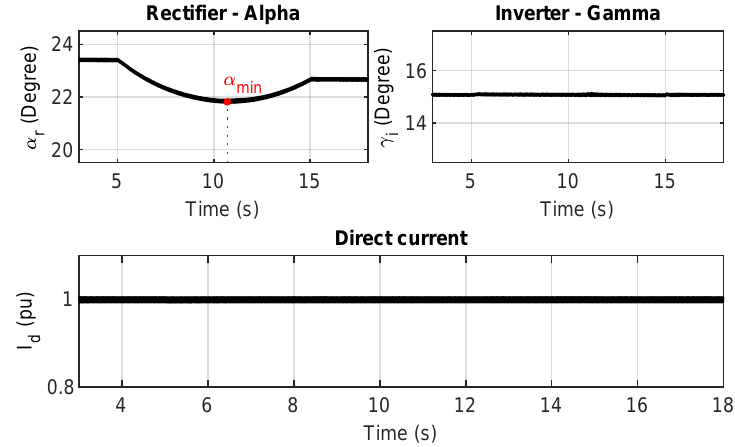
Figure 7. LCC-HVDC DC variables under VSC powers